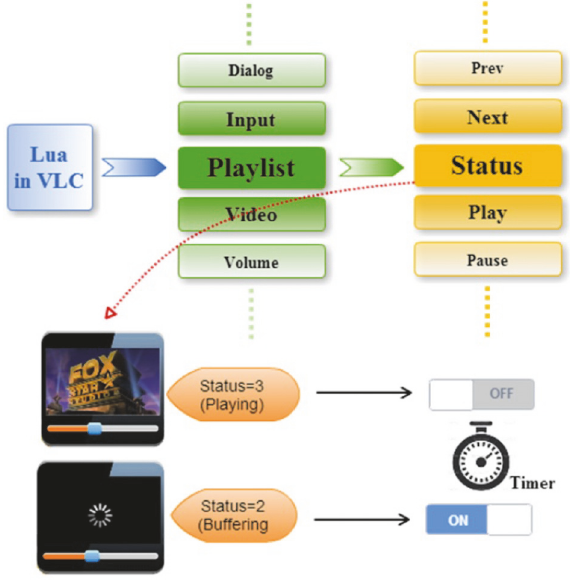
Figure 5: Buffering mechanism in VLC